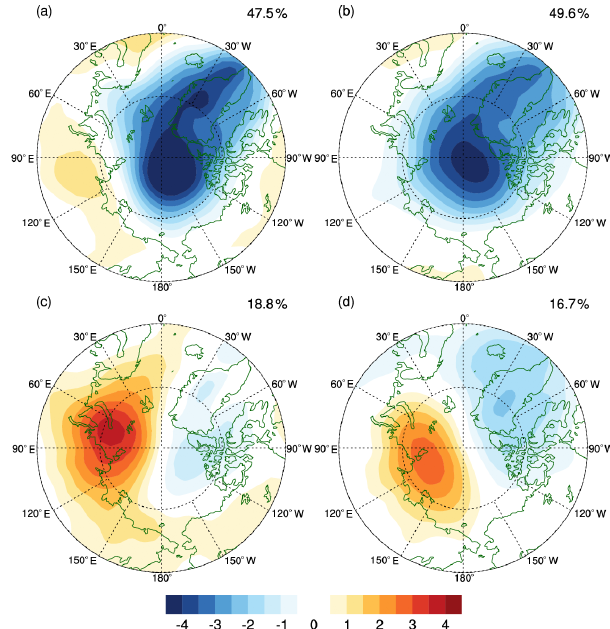
Figure 12. Leading EOF modes according to the PDO phase. (a, c) are the EOF1 and EOF2 in the positive PDO years, and (b, d) are the EOF1 and EOF2 in the negative PDO years. The pos- itive PDO years were defined when the PDO index is above 0.5 and negative below − 0 . 5. The PDO index was obtained from NCEI. See the text for detail.